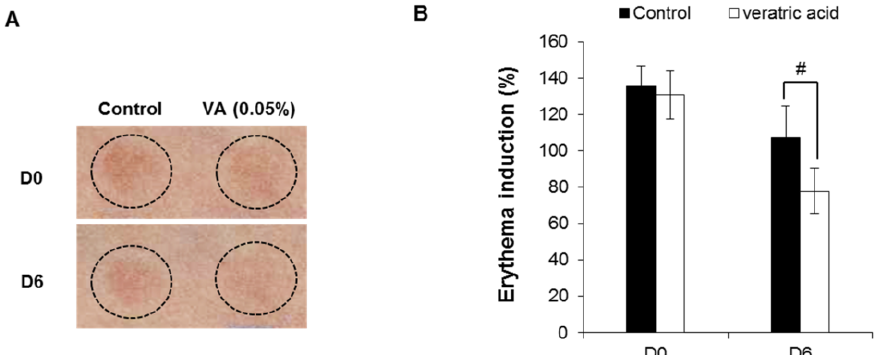
Figure 7. Skin recovery effect of veratric acid were evaluated in human studies. ( A ) Digital images. ( B ) Induction percentage of